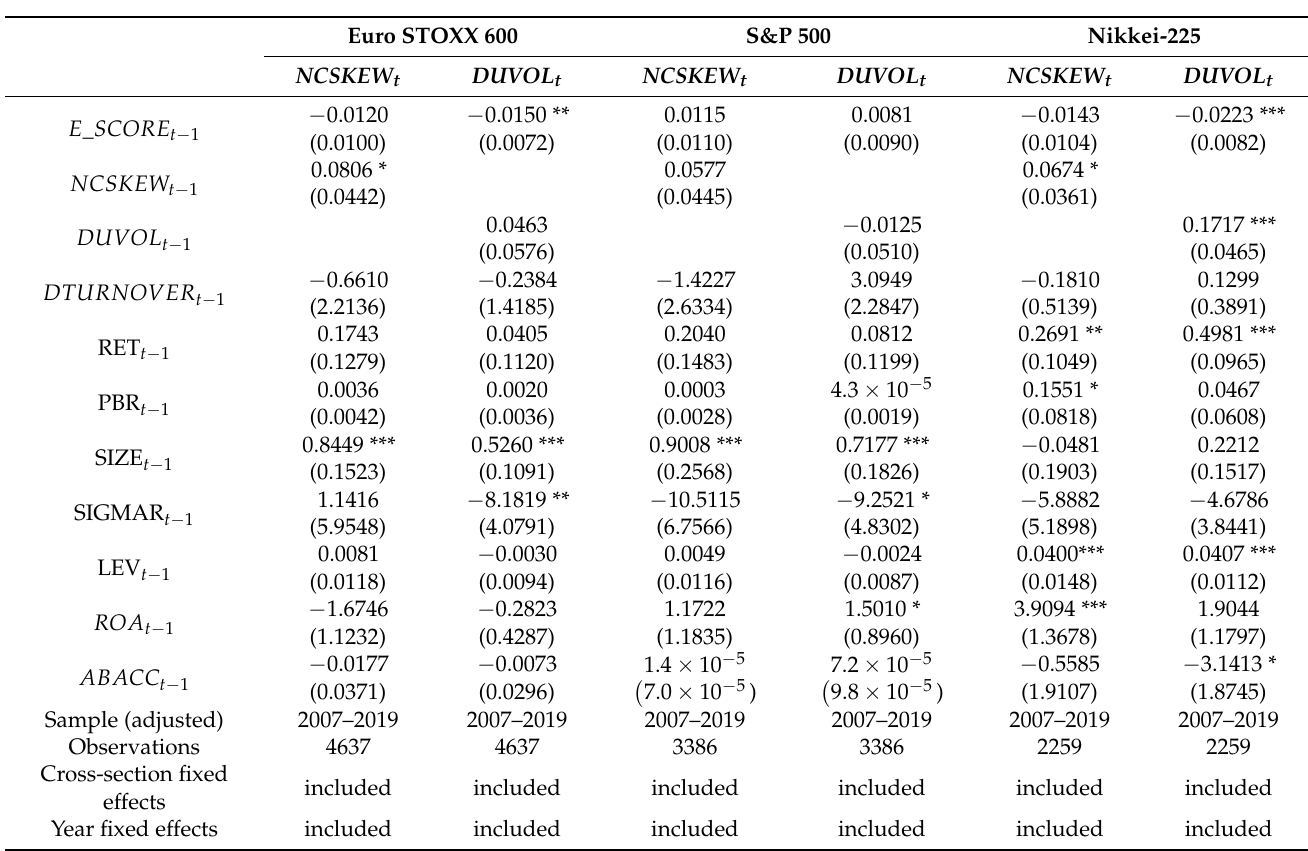
Table 7. Regression analysis on the effect of environmental disclosure on crash risk using dynamic panel models.